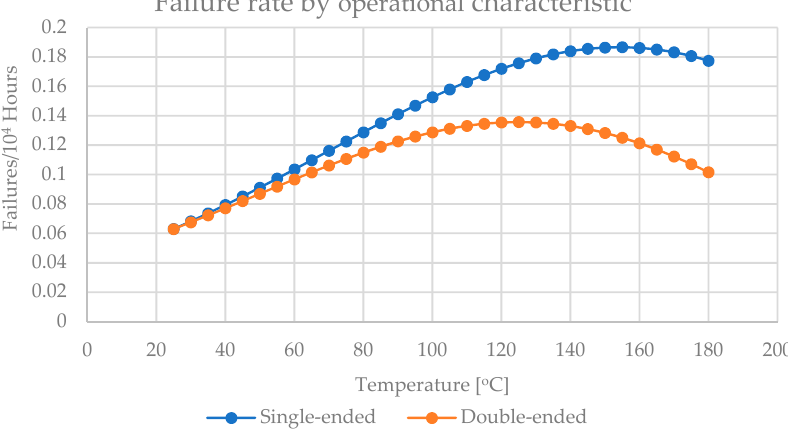
Figure 7. Failure rate obtained by subtracting PCA-based failure rate from FTA-based failure rate, i.e., failure rate according to the operational characteristic of the converter.